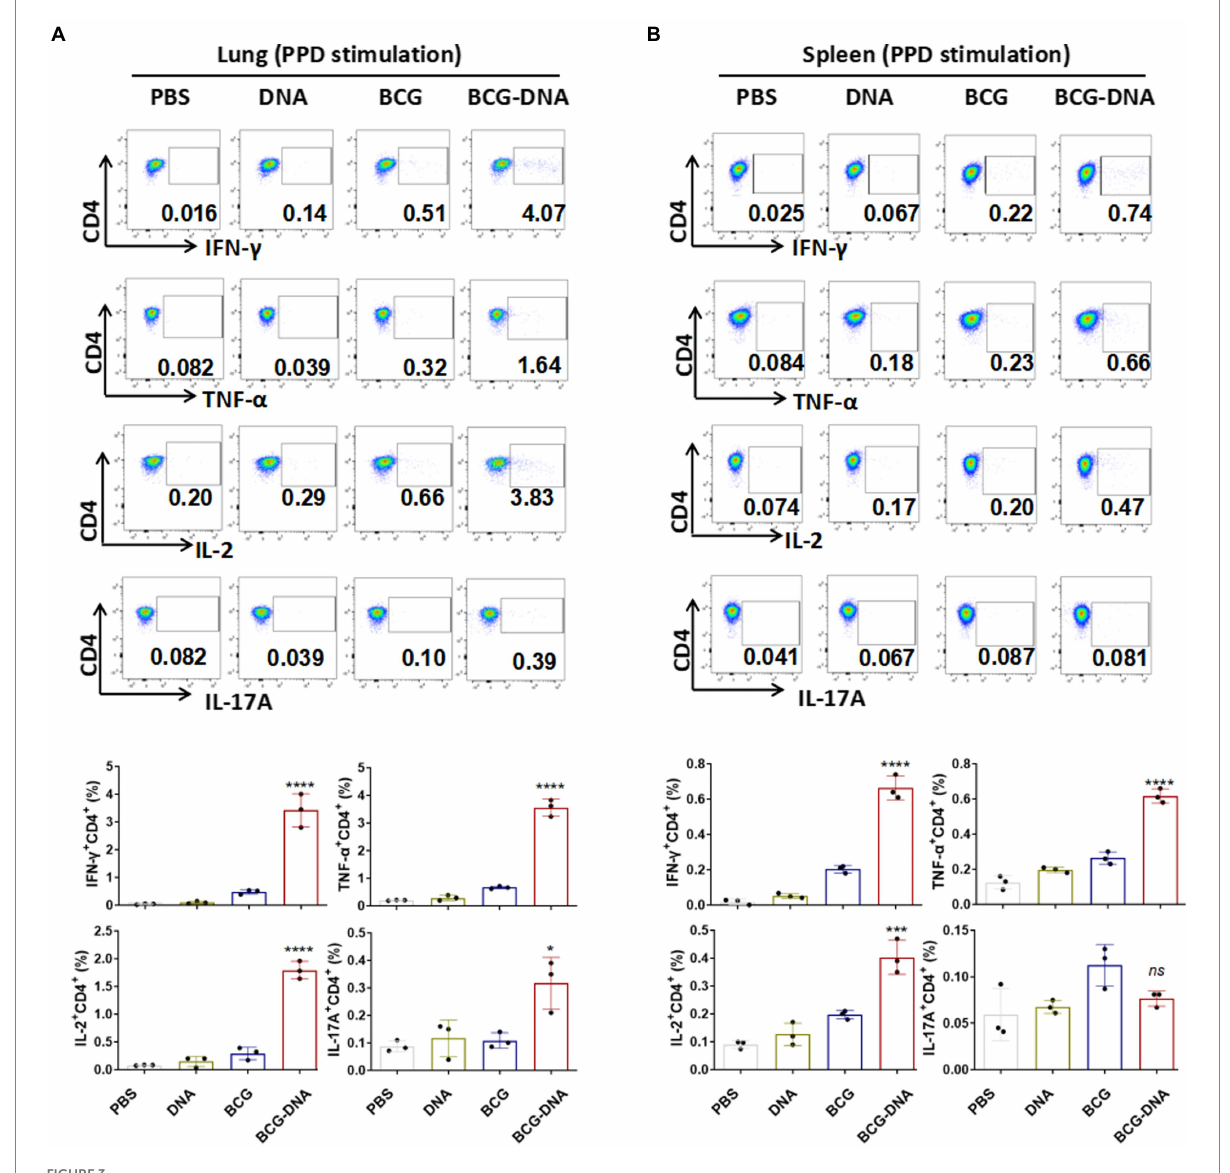
FIGURE 3 Flow cytometric analysis of cytokine production in T cells from immunized mice prior to infection. Six weeks after the primary immunization, the mice were sacrificed, cells were harvested from the mice ( n = 3) and treated with PPD (10 μ g/ml) at 37 ° C for 15 h in the presence of GolgiStop. Production of IFN- γ , TNF- α , IL-2 and IL-17A in the lung cells (A) and splenocytes (B) were determined by flow cytometry. Representative flow cytometric plots of IFN- γ , TNF- α , IL-2 and IL-17A staining in CD4 + T cells (top) and the proportions of CD4 + T cells producing cytokines (bottom) are shown. ( n = 3 mice, one-way ANOVA, mean ± SEM). * p < 0.05, *** p < 0.001, **** p < 0.0001: a significant difference of treatment groups from the appropriate controls (PBS group). ns , no significant